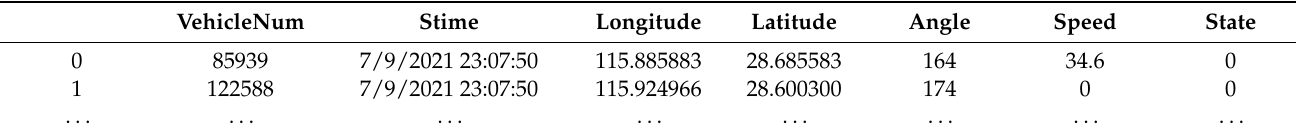
Table 1. Sample trajectory data.